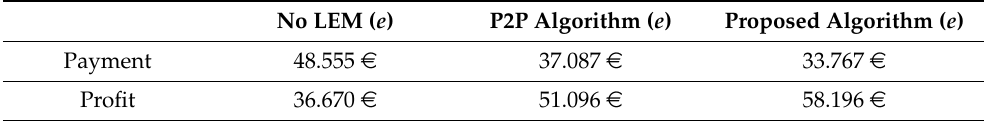
Table 2. Total payment and profit in